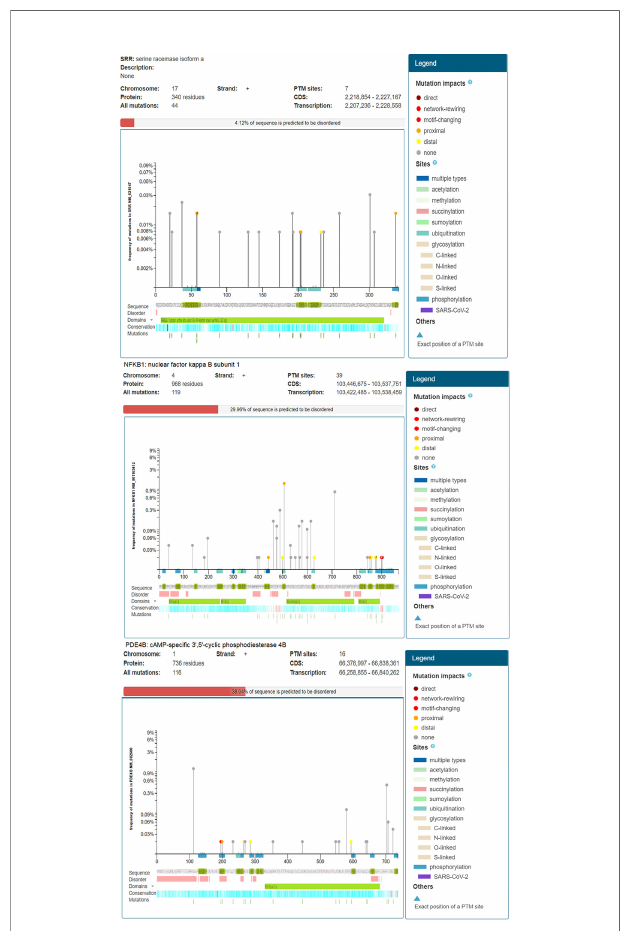
FIGURE 5 | Mutation analysis of type 2 diabetes mellitus (T2DM)-related differentially expressed genes (DEGs) indicating posttranslational modi fi cations with signi fi cant cutoff parameters. It highlights the signi fi cant disordered regions of the proteins contributing a pathophysiological role and to disease